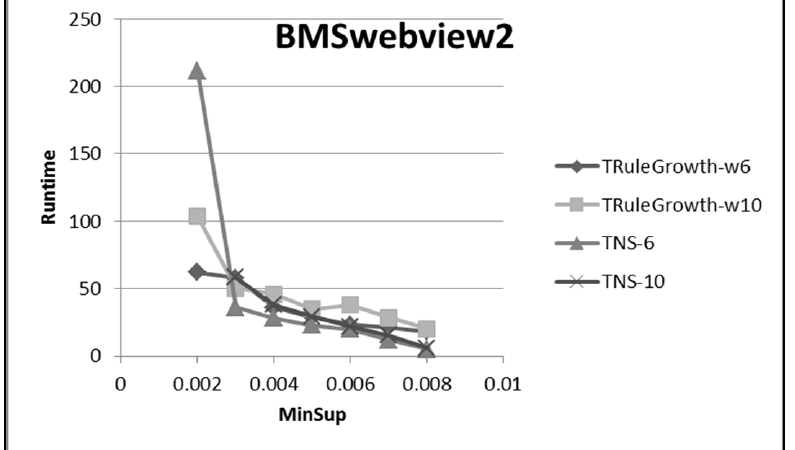
Figure 20. Comparison of the runtime of the TNS with the NRD-DBV for (Korsarak) dataset.